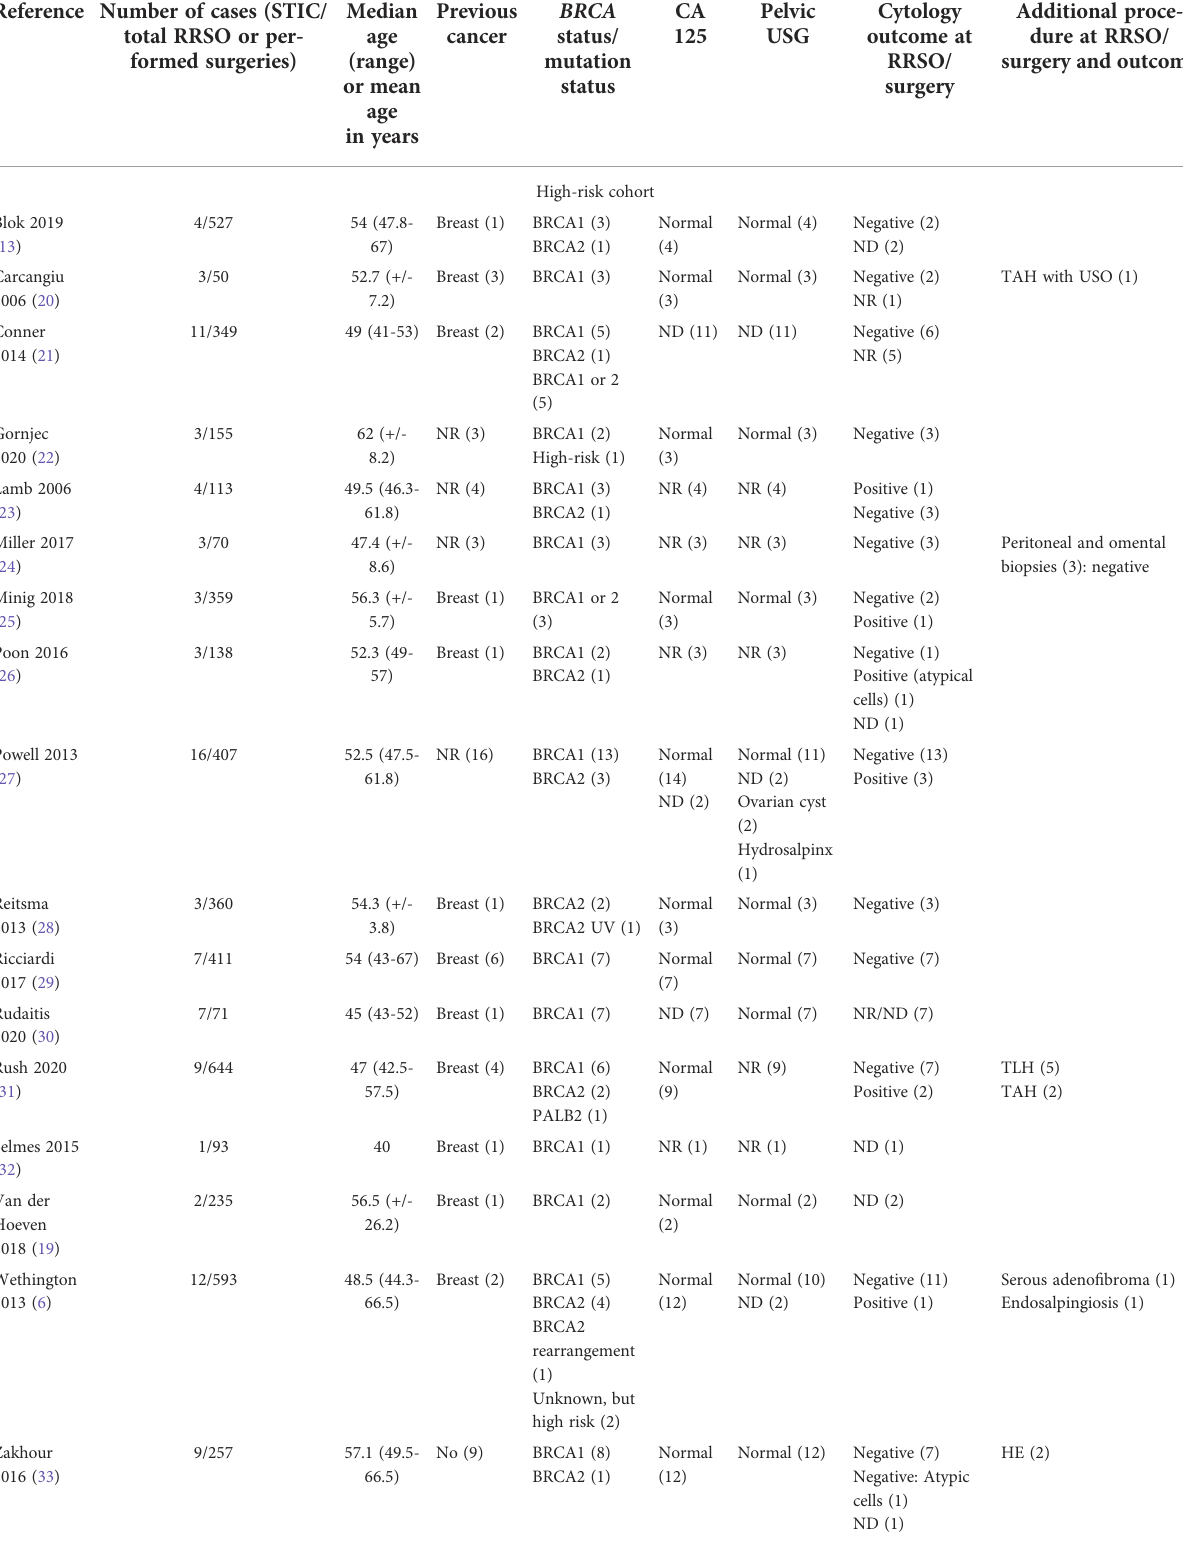
TABLE 1 Detailed characteristics of all included patients with isolated STIC (white: high-risk cohort; grey: low-risk cohort). Reference Number of cases (STIC/ total RRSO or